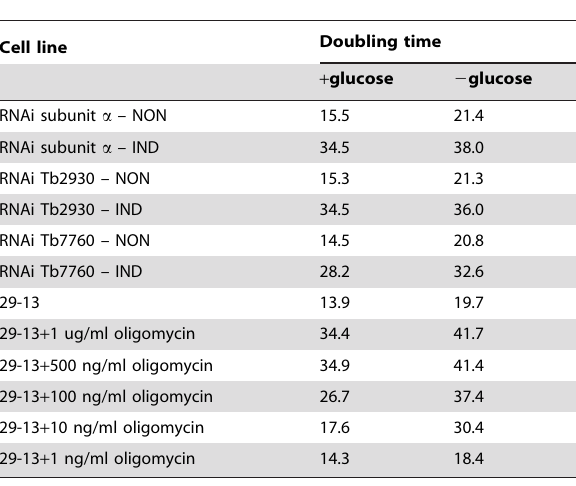
Table 3. Effect of RNAi and oligomycin on the doubling time of procyclic T. brucei cell lines growing in the presence ( + ) or absence ( 2 ) of glucose in the